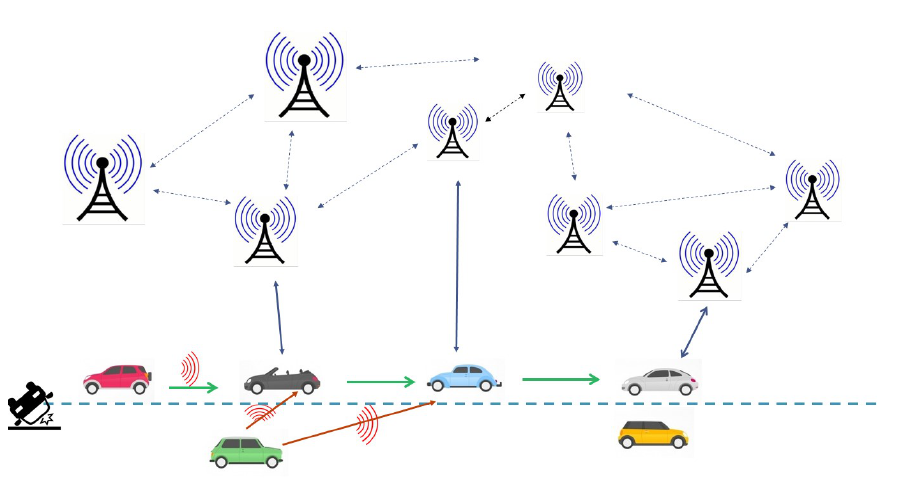
Figure 2. VANET architecture.